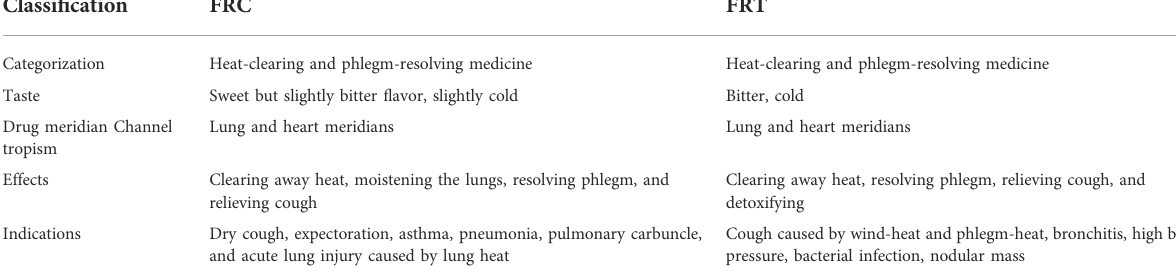
TABLE 2 Difference between FRC and